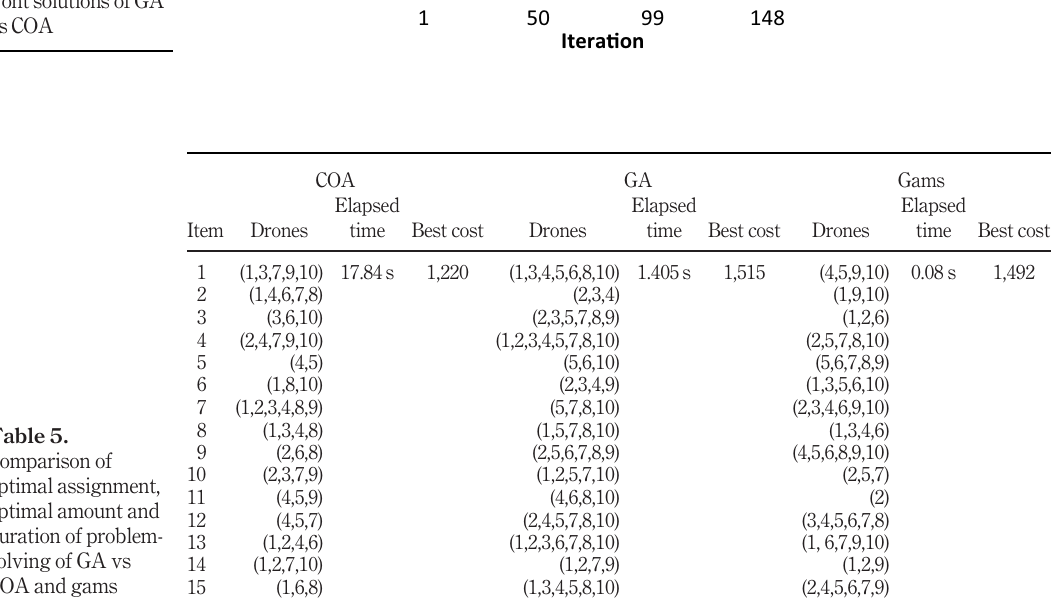
Figure 4. Comparison of convergence of Pareto front solutions of GA vs